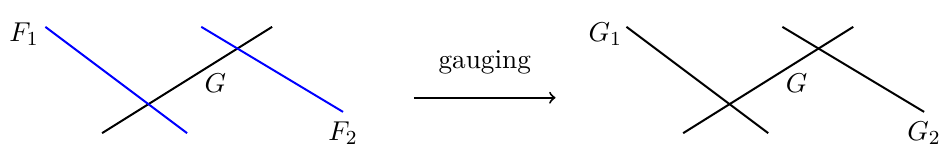
Figure 2 . An illustration of gauging flavor symmetries, with two non-compact curves intersecting with one compact